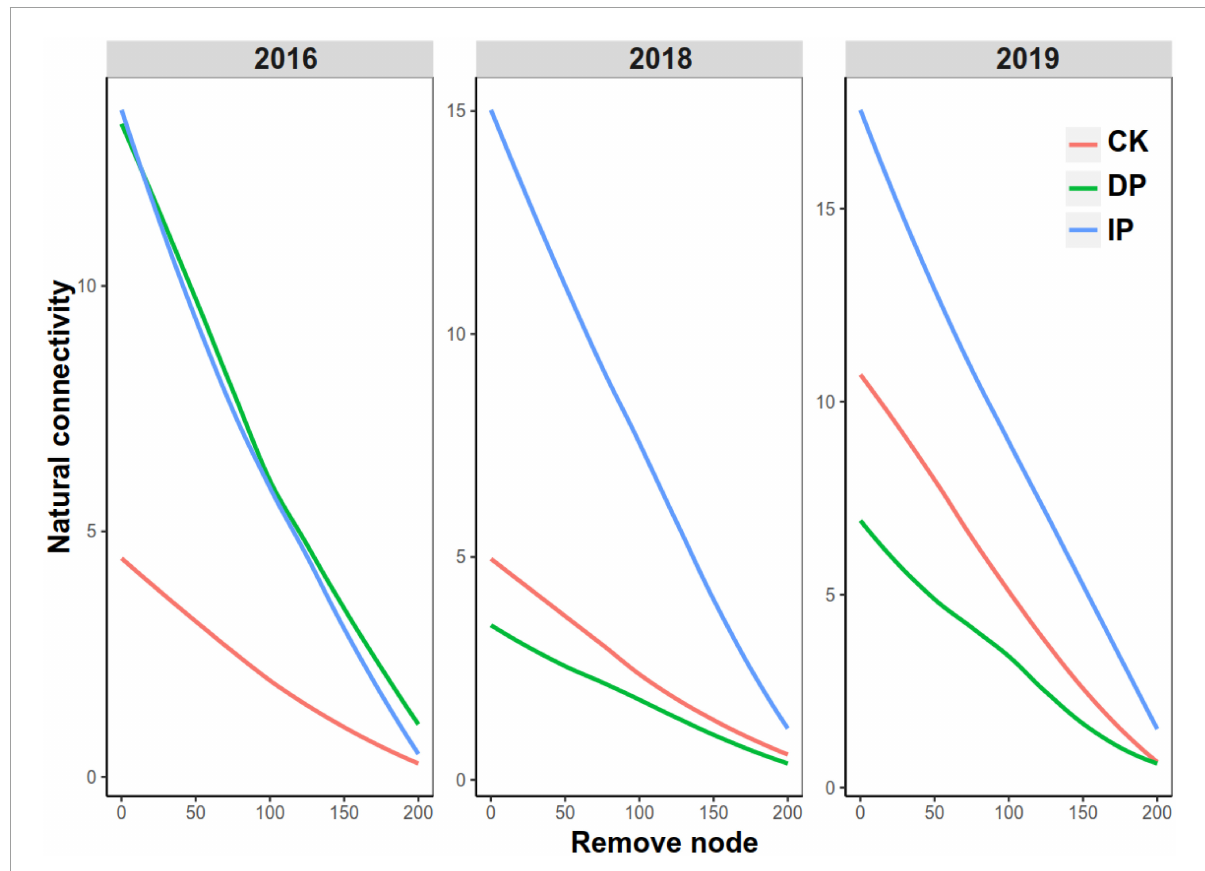
FIGURE3 Natural connectivity of bacterial networks in different precipitation gradients in 2016, 2018, and 2019. CK, control; DP, decreased precipitation; IP, increased